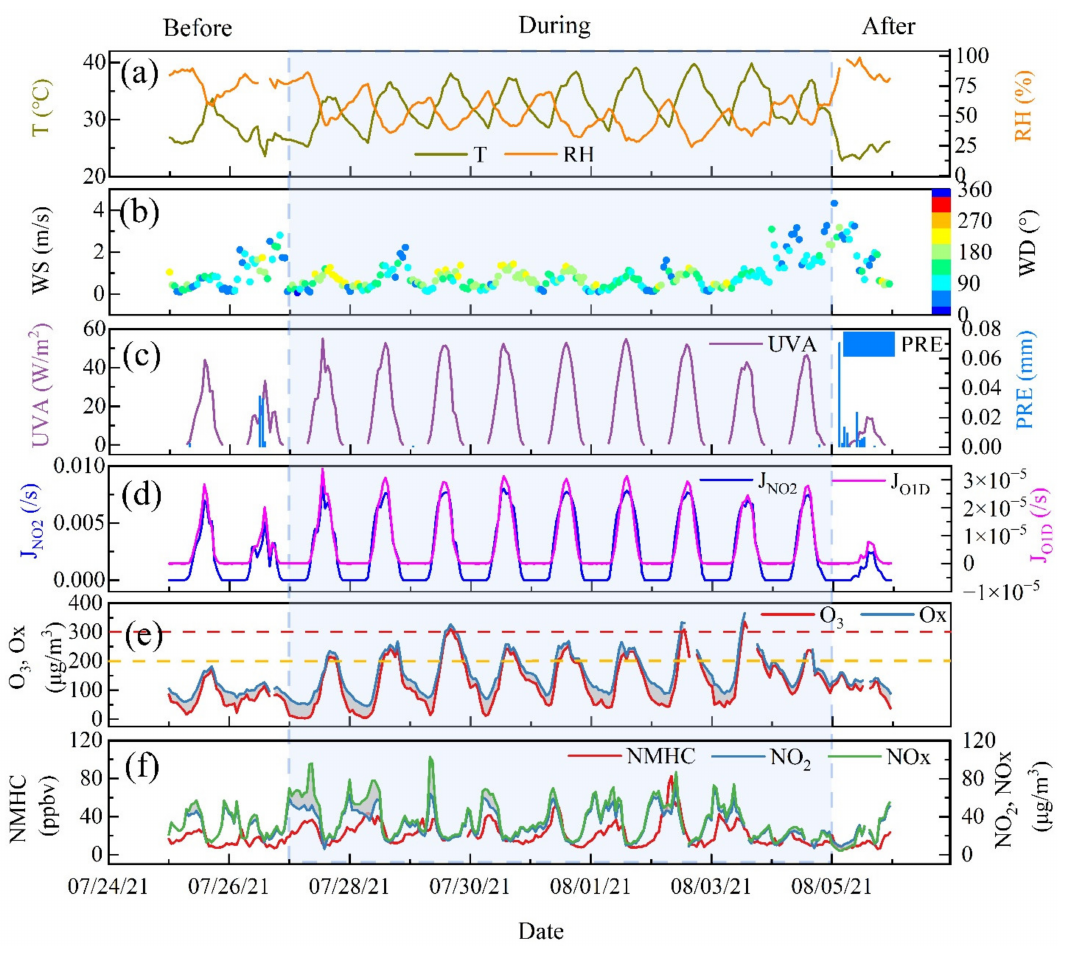
Figure 2. Time series of meteorological parameters ( a , b ), UVA ( c ), photolysis rate constants ( d ), and pollutant concentrations ( e , f ) in Chengdu during the observation period. The blue shading shows the polluted period. Before: 25 July–26 July; during: 27 July–4 August; after: 5